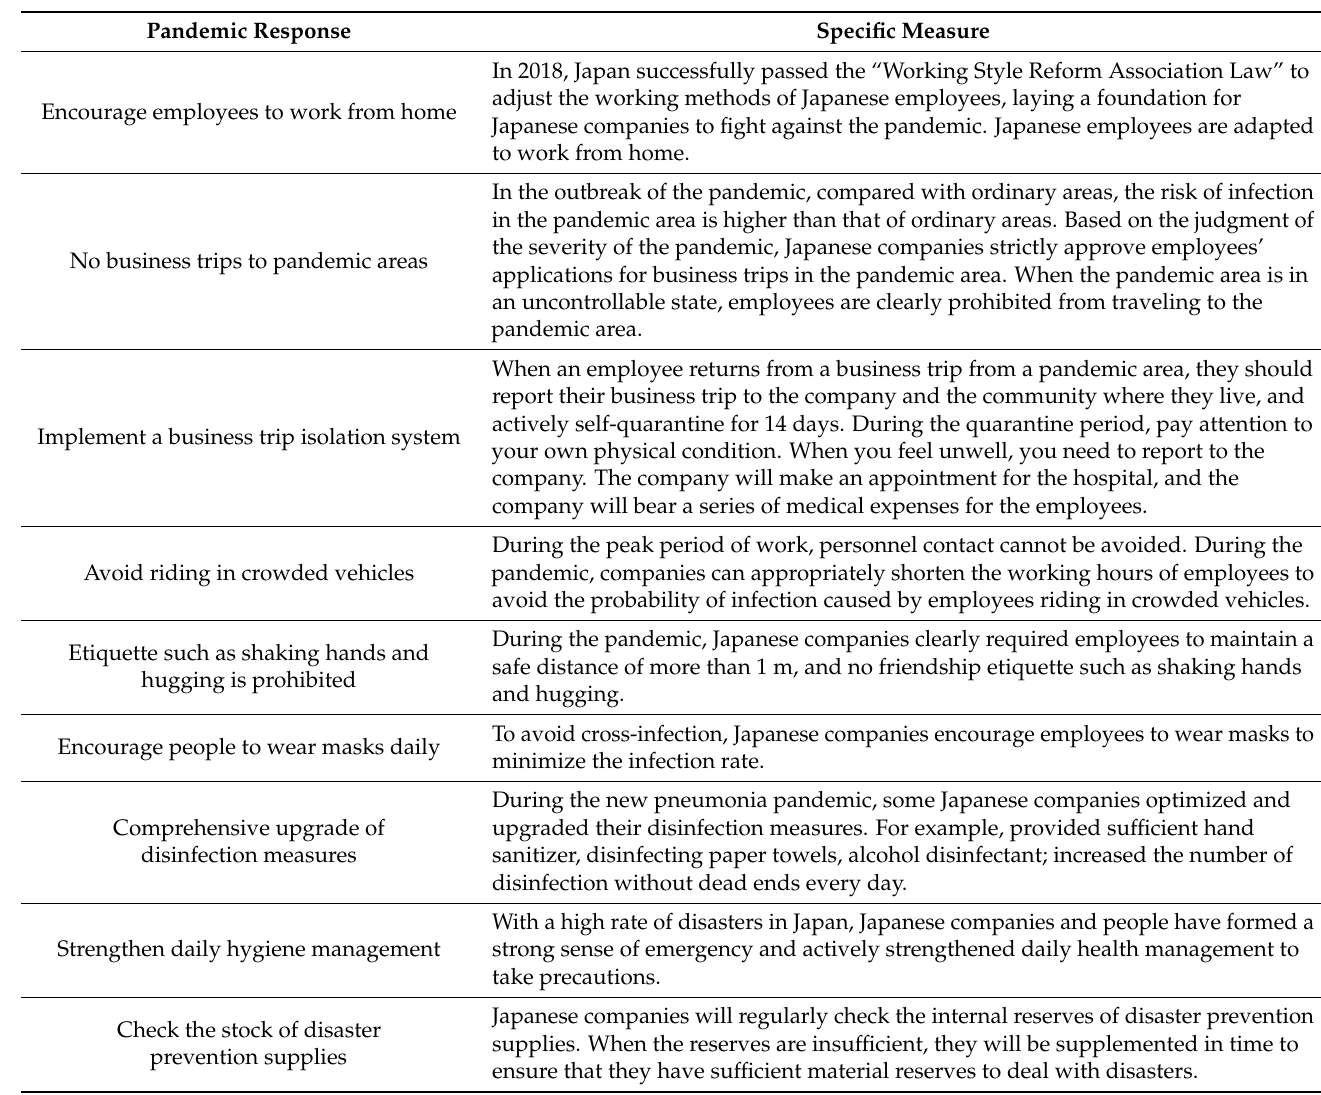
Table 2. Japanese companies took specific measures to fight the